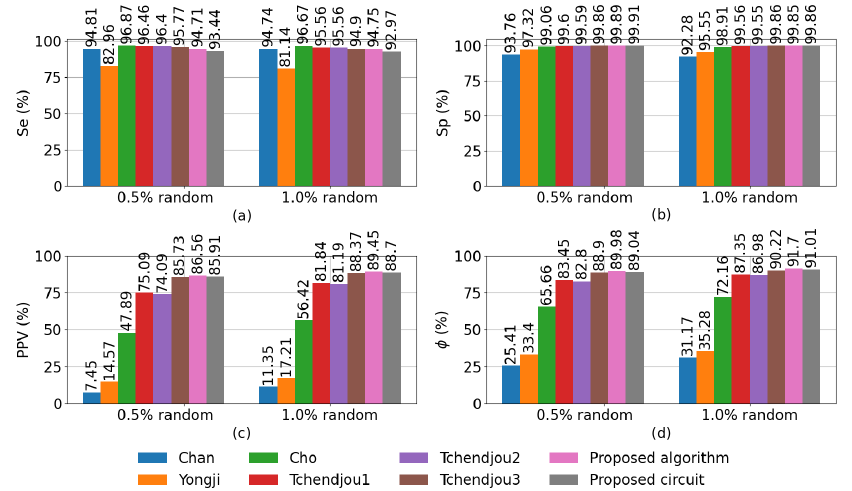
Figure 15. Comparison of defective pixel detection methods using ( a ) Sensitivity, ( b ) Specificity, ( c ) Positive Predictive Value (PPV), and ( d ) Phi